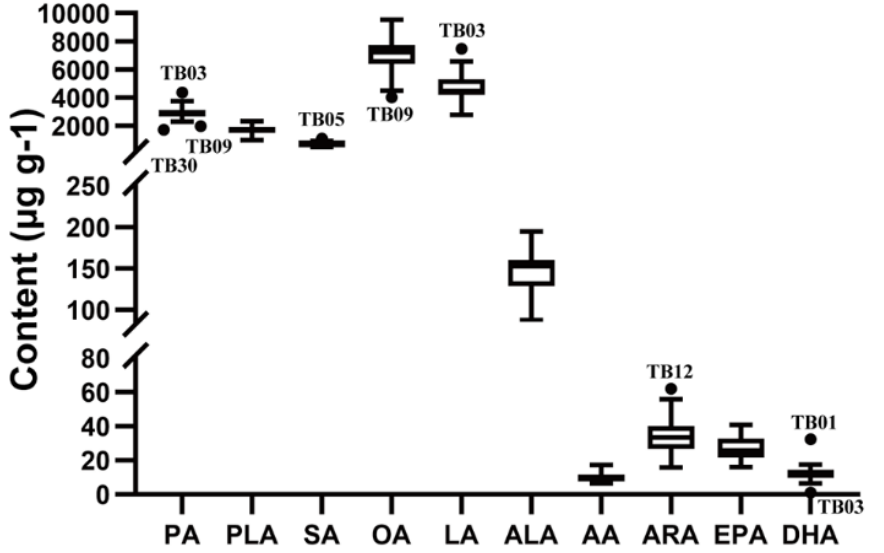
Figure 2. The range and distribution of ten FAs in 31 Tartary buckwheat accessions. Median values are the horizontal lines in the box, 50% of data is within the box. The data outside the box are indicated by black dots.